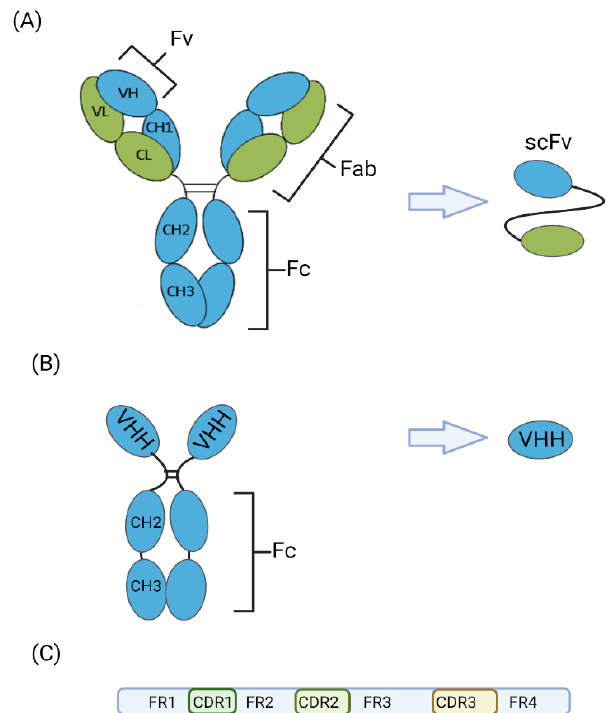
Figure 1. Schematics of ( A ) conventional immunoglobulin G (IgG1) showing two heavy chains (blue) and two light chains (green), which are folded into constant and variable domains. The fab domains consist of two variable domains (the variable fragment, Fv) and two constant domains acting as a structural framework. The smallest intact functional unit of IgG1 consists of a single heavy (VH) and light (VL) chain linked by an oligopeptide. ( B ) Camelid heavy-chain antibody (IgG2 and IgG3 fractions) consists of only heavy chains and the smallest functional antigen-binding fragment is the VHH, which stands for the variable domain (VH) of heavy-chain antibodies. ( C ) Each variable domain of the IgG1, IgG2 and IgG3 contains three hypervariable loops, known as complementary determining regions (CDRs) between four less variable framework regions (FR). Modified from